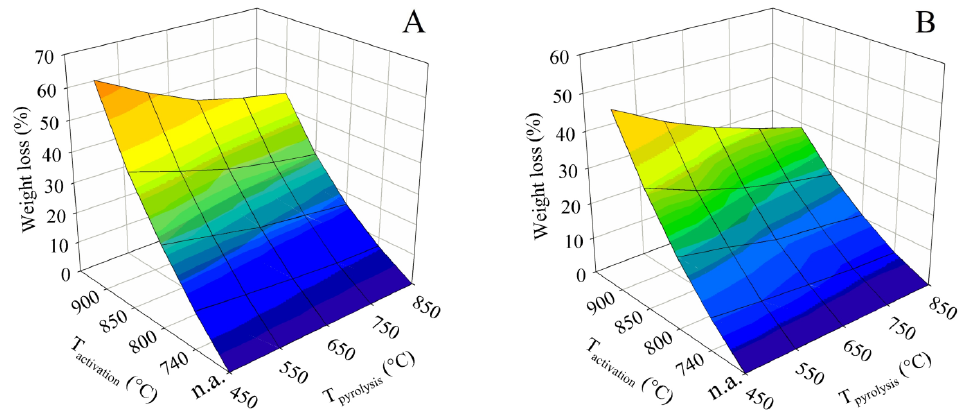
Figure 8. The evolution of the process losses caused by different pyrolysis and activation conditions for series ( A , B ).